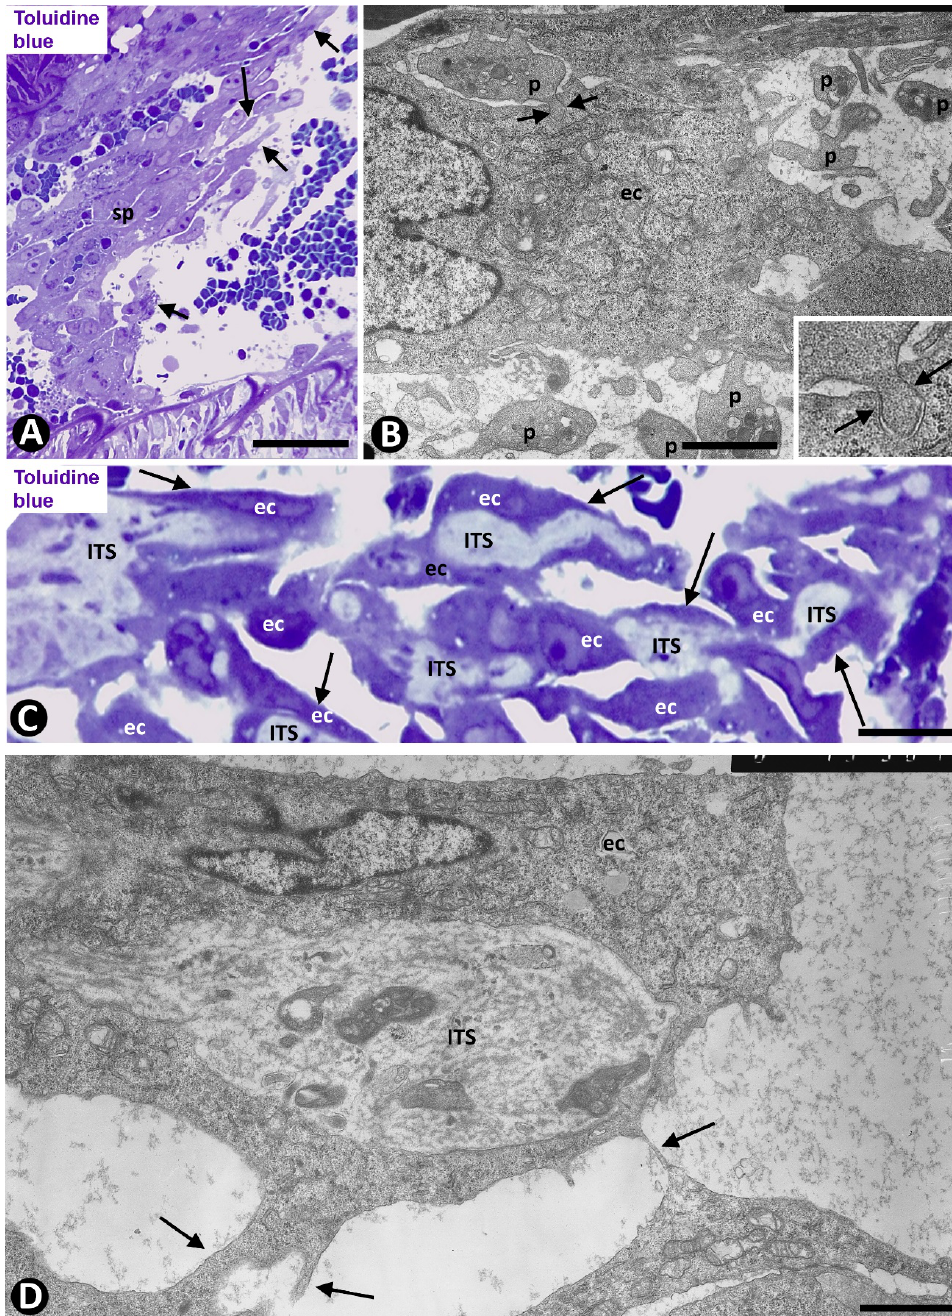
Figure 7. Angiogenesis in experimental occluded arterial segments. ( A , B and insert of B) ECs extending from spheroids (sp) into the arterial lumen (arrows in A). In B and insert, note that platelets (p) associate with an EC (ec) and form peg-and-socket junctions (arrows) (Platelets form the peg and ECs form the socket). ( C ) Intraluminal pillars (arrows) covered by ECs (ec). Note the cores or ITSs formed in the spaces between primitive bilayers of ECs, whose abluminal surfaces face each other. ( D ) Ultrastructural image of a pillar formed by ECs (ec) (the cover) and an ITS (the core). Observe projections of ECs (nascent pillars-arrows) that join the pillar with other pillars (arrows). ( A , C ) Semithin sections. Toluidine blue. ( B , D ) Ultrathin sections. Uranyl acetate and lead citrate. Bar: ( A ): 40 μ m; ( C ): 8 μ m; ( B , D ): 3 μ m.